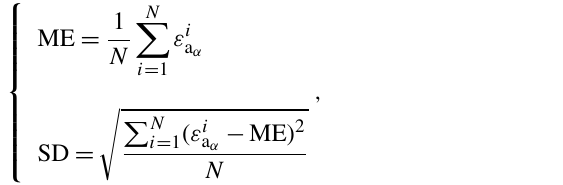
be zero. In other words, let S n (with n = 1 , 2 , 3 ... ) be a